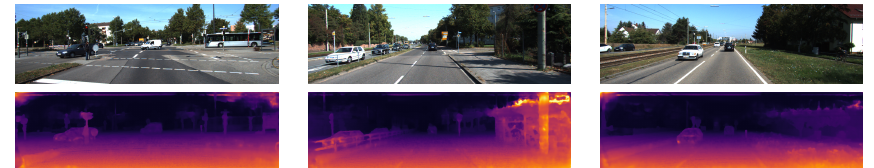
Figure 9. The qualitative results from [30] show the left RGB images from 3 scenes in the KITTI-2015 stereo dataset in the top row and the corresponding disparity map predictions in the bottom row are shown using colour to represent the disparity values. The raw dataset was used for the LiDAR data mapped onto the scenes in the stereo dataset and then the results were converted from depth values to disparity using the calibration